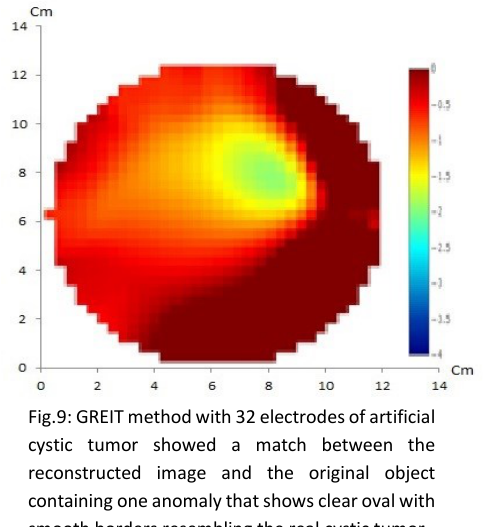
Fig.9: GREIT method with 32 electrodes of artificial cystic tumor showed a match between the reconstructed image and the original object containing one anomaly that shows clear oval with smooth borders resembling the real cystic tumor.